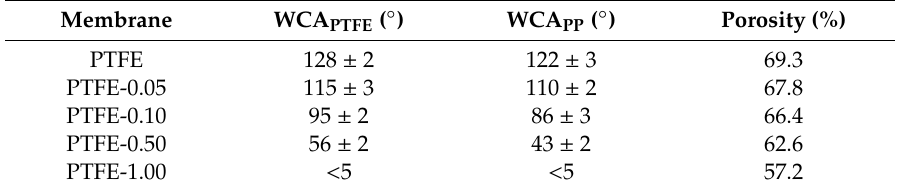
Table 1. Results of water contact angle (WCA) for feed side (PTFE, polytetrafluoroethylene) and permeate side (PP, polypropylene) membrane surfaces as well as the calculated membrane porosity.